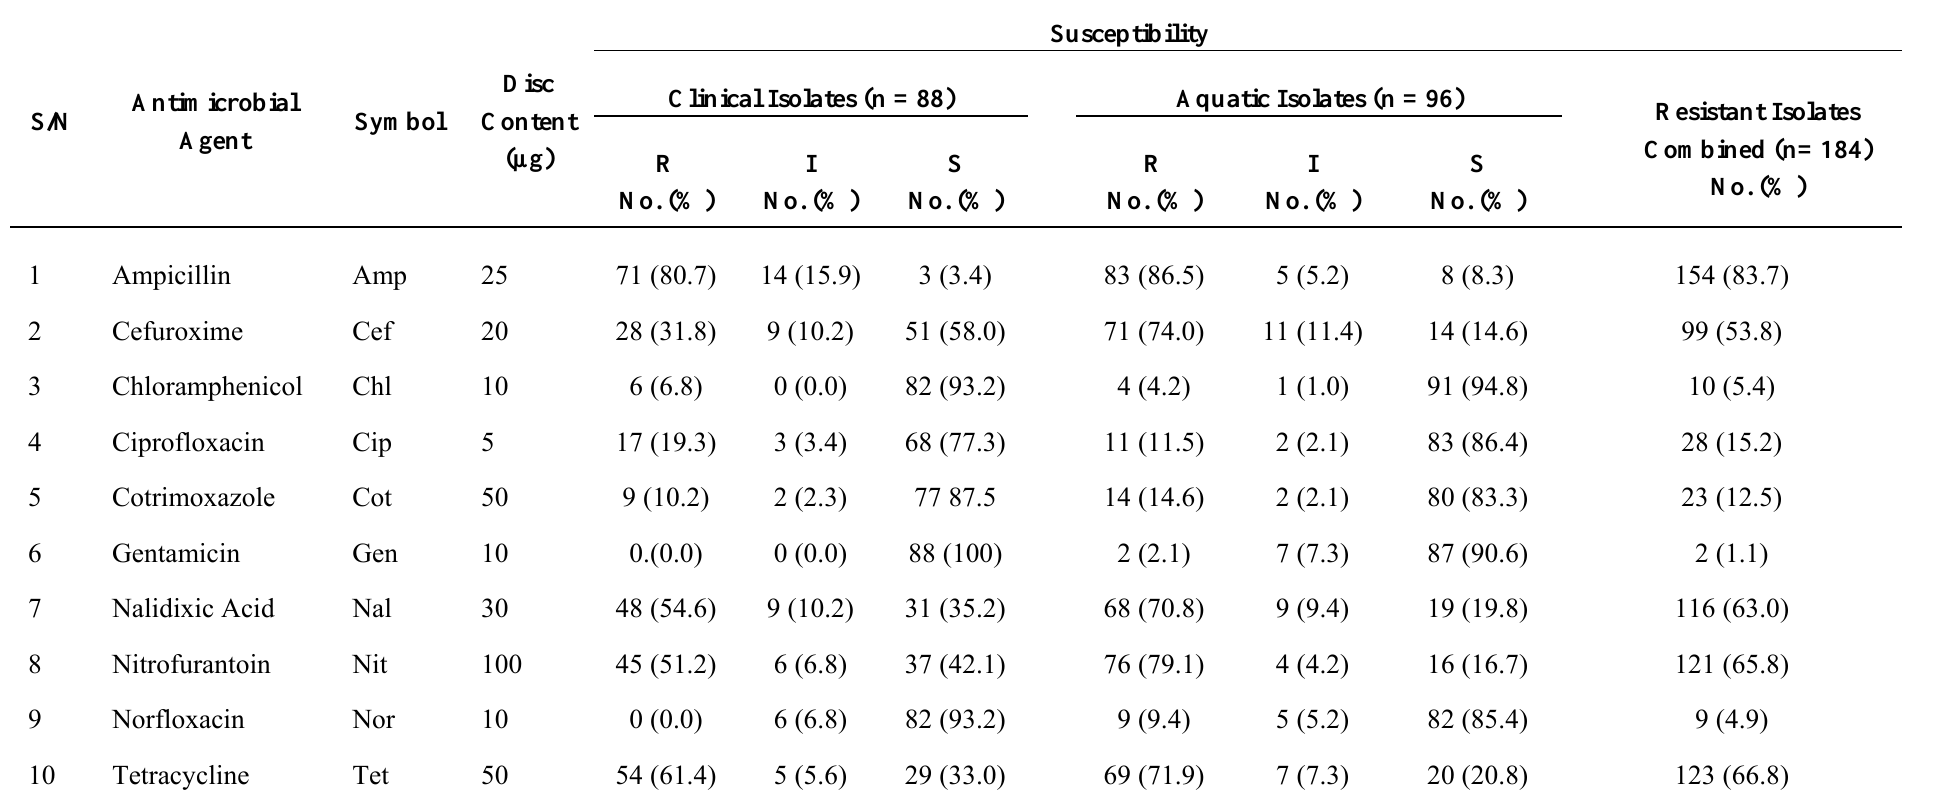
Table 2. Antimicrobial Susceptibility Pattern of E .coli Isolated from Clinical and Water Samples